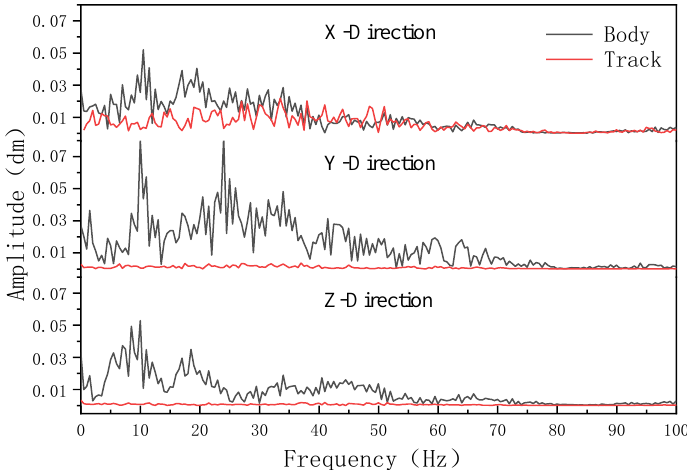
Figure 8. Frequency amplitude comparison of the track and chassis.